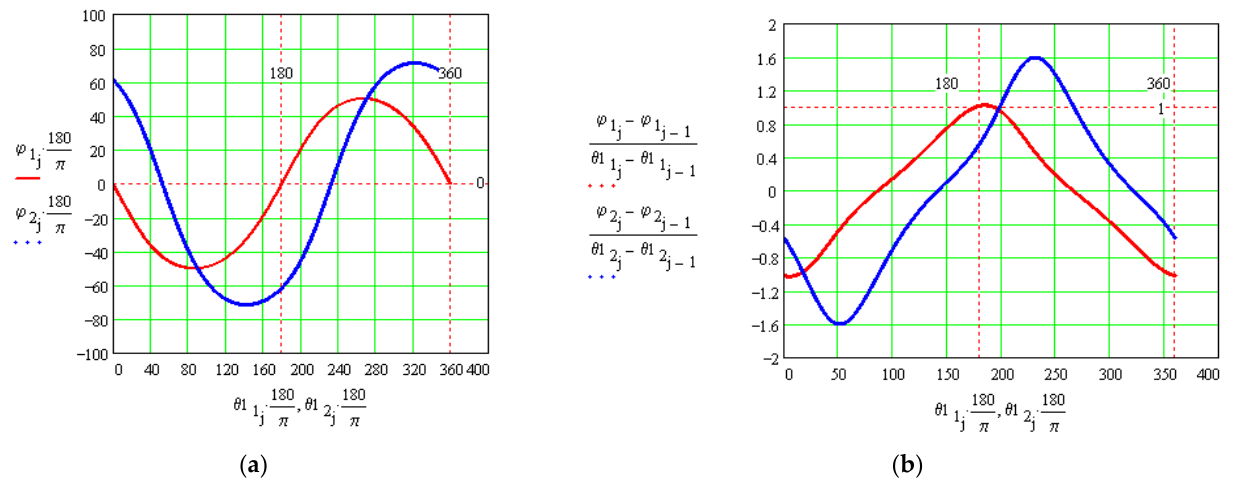
Figure 21. The angle of rotation ( a ) and the angular velocity of the axis of centers in the middle plane of the channel ( b ).